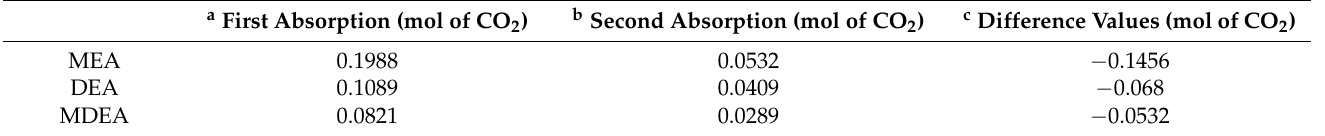
Table 2. Results of CO 2 loading of amines selected for the present